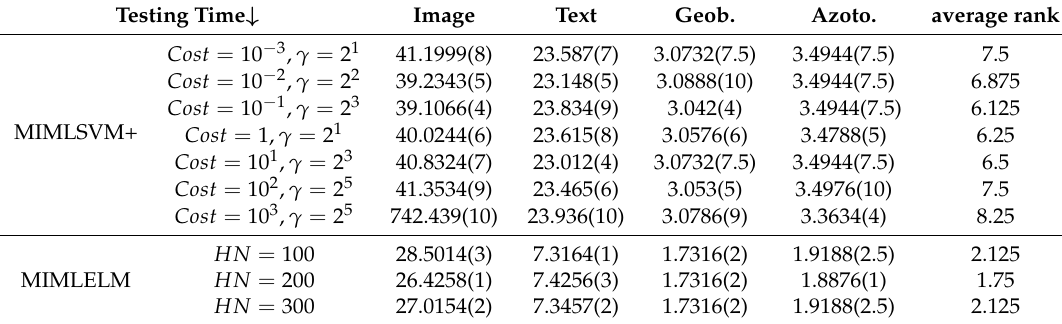
Table 15. Friedman test of the testing time.